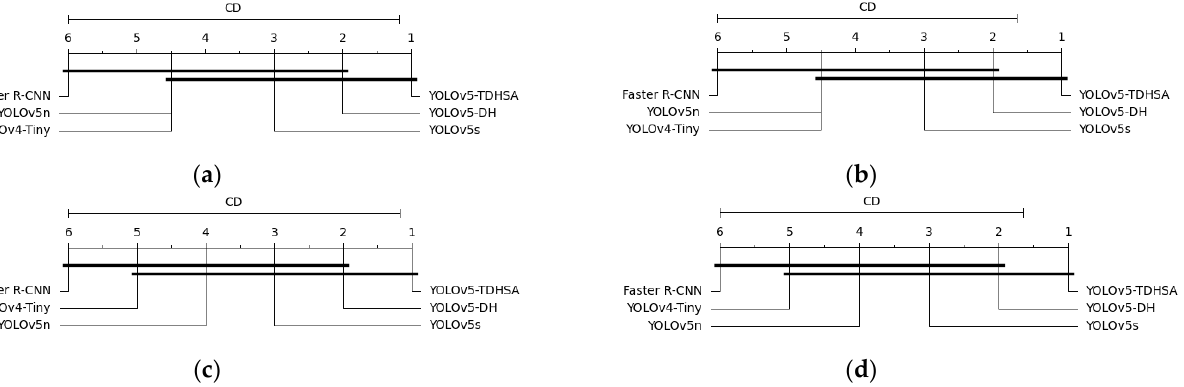
Figure 9. Critical difference (CD) comparison of YOLOv5-TDHSA (the control model) against other compared models with the Bonferroni–Dunn test, based on ( a ) F1 score with confidence level α = 0.05, CD = 4.819; ( b ) F1 score with confidence level α = 0.10, CD = 4.352; ( c ) mAP with confidence level α = 0.05, CD = 4.819; ( d ) mAP with confidence level α = 0.10, CD = 4.352 (any two models not connected by a thick black horizontal line are considered to have significant performance differences between each